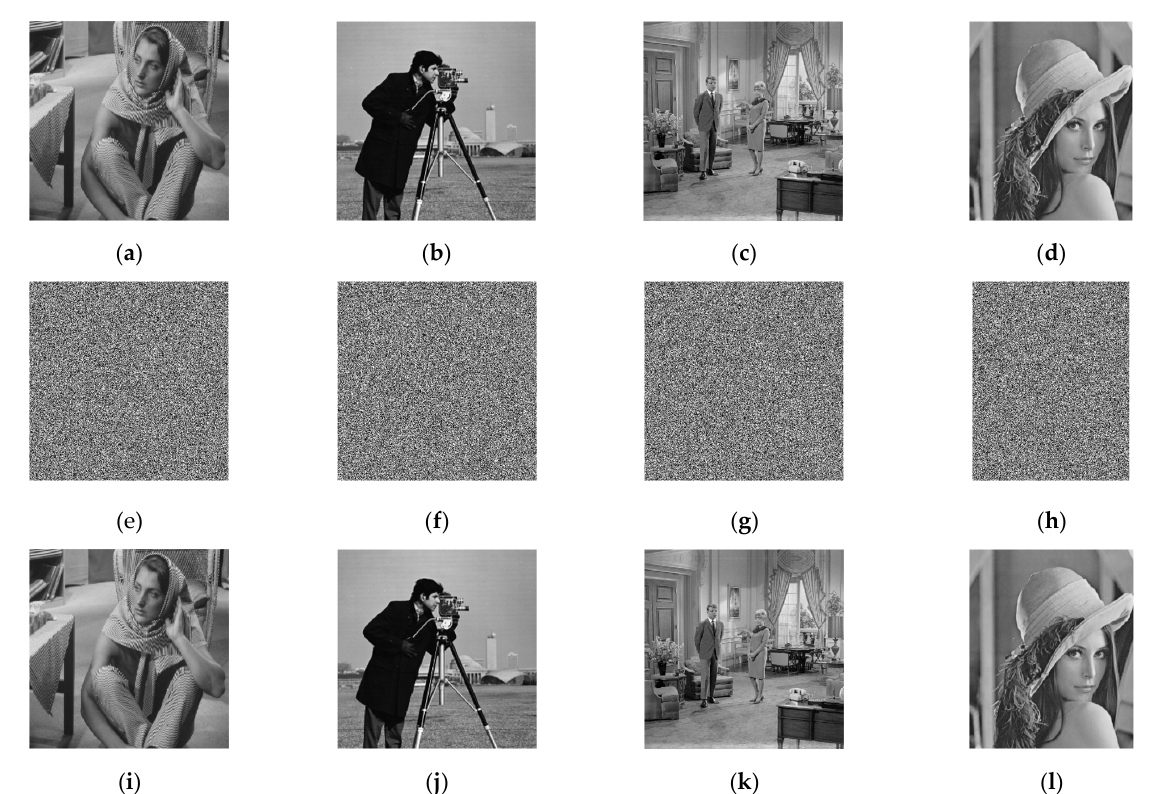
Figure 10. Simulation results (512 ∗ 512 and irregular): ( a – d ) original images; ( e – h ) encrypted images; ( i – l ) decrypted images.